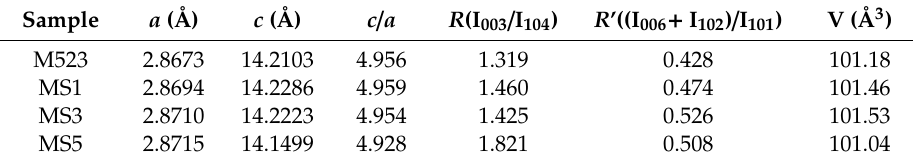
Figure 2. SEM images of MS1 ( a and b ) , MS3 ( c and d ), MS5 ( e and f ), and the corresponding EDS mappings of image MS3 ( c ): ( g )-O, ( h )-Ni, ( i )-Co, ( j )-Mn, ( k )-Sn.